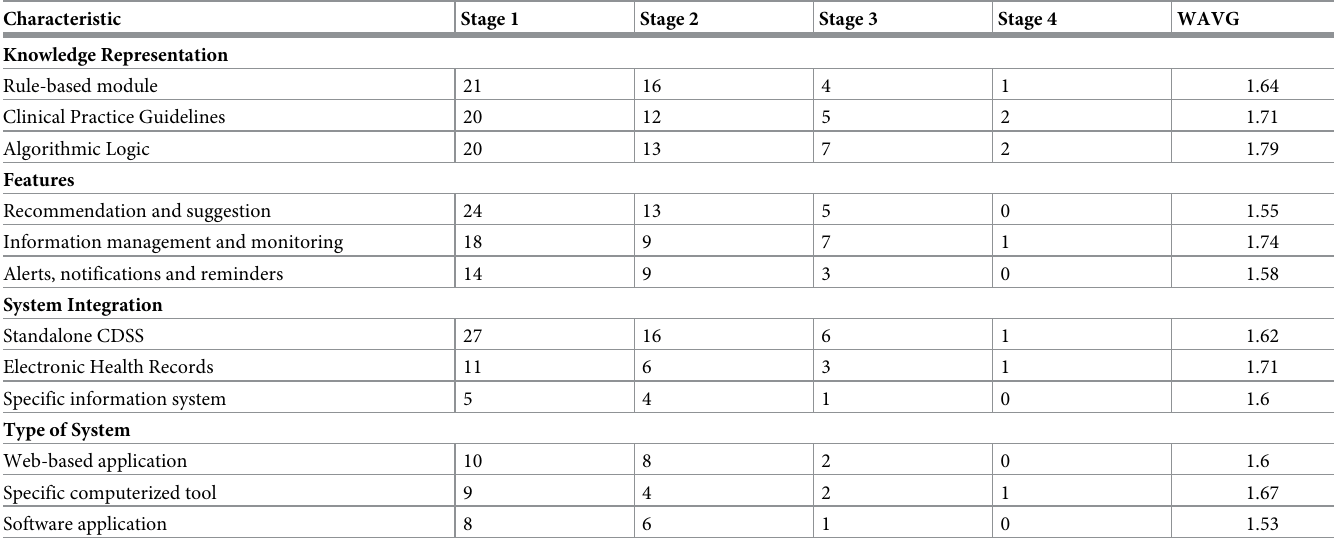
Table 7. Maturity Staging Model applied on the reviewed